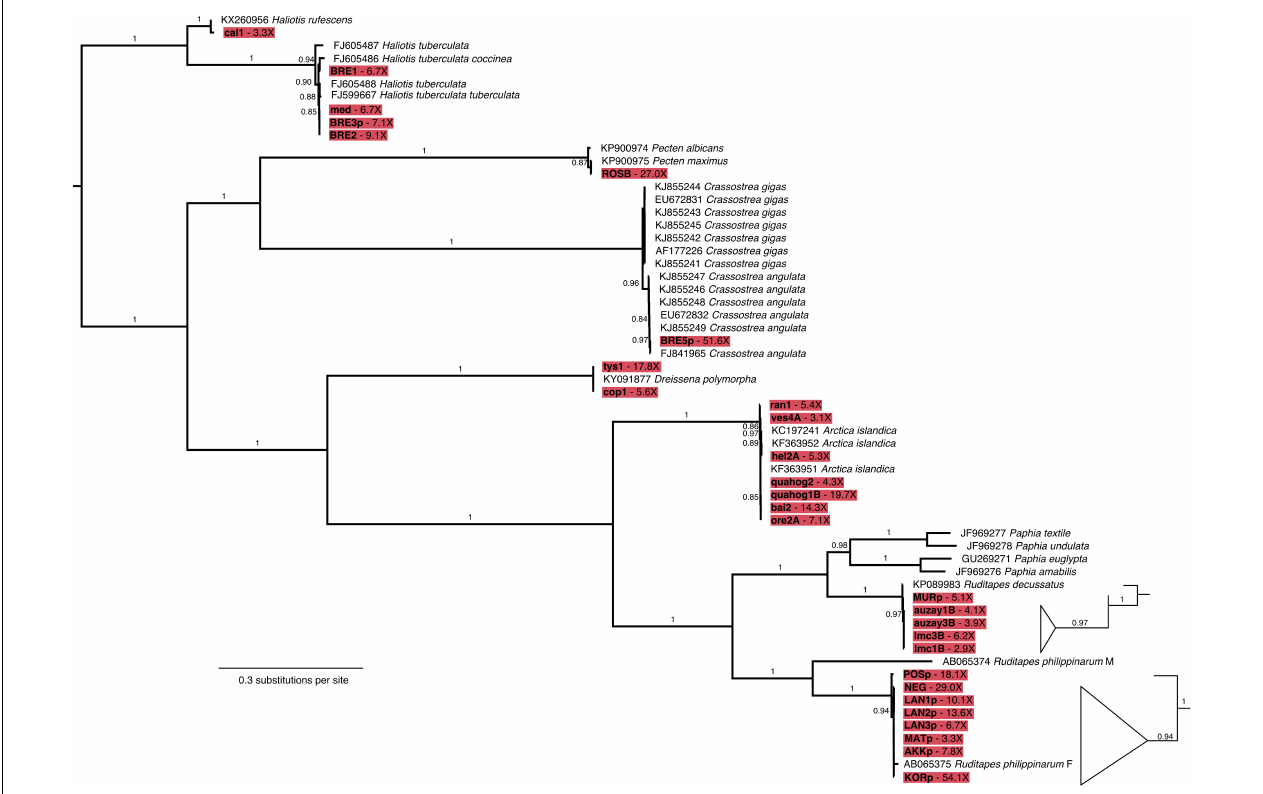
FIGURE 5 | Maximum likelihood phylogenetic tree of mollusk mitochondrial genes. Tree built from a 60-individual alignment of 12 concatenated gene sequences. Sequences assembled from shell DNA in this study are highlighted in red and their coverage is indicated in the tip label, GenBank accession numbers are provided for previously published sequences. Branch support ≥ 0.70 is shown as Shimodaira-Hasegawa approximate Likelihood Ratio Test. The subtrees for the R. decussatus and R. philippinarum clades were enlarged and branches collapsed in order make branching order more